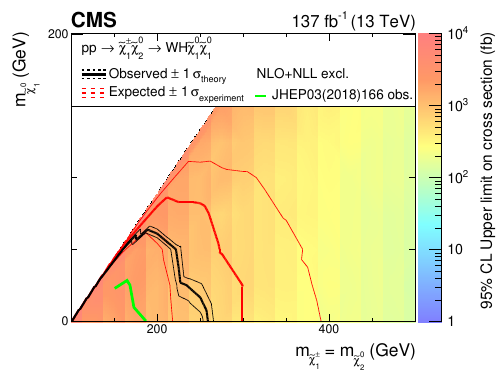
0 production with WH -mediated decays. The Figure 20 . Interpretation of the results for e c ± 2 1 e c ± 0 shading in the m versus m plane indicates the 95% CL upper limits on the production cross 0 0 e c 2 1 e c e c e c 1 2 sections. The contours delineate the mass regions excluded at 95% CL when assuming cross sections computed at NLO plus NLL. The observed, observed ± 1 σ ( ± 1 standard deviation of the theory theoretical cross sections), median expected, and expected ± 1 σ bounds are shown in black experiment and red. The observed limits obtained in the CMS analysis using 2016 data [20] are shown in